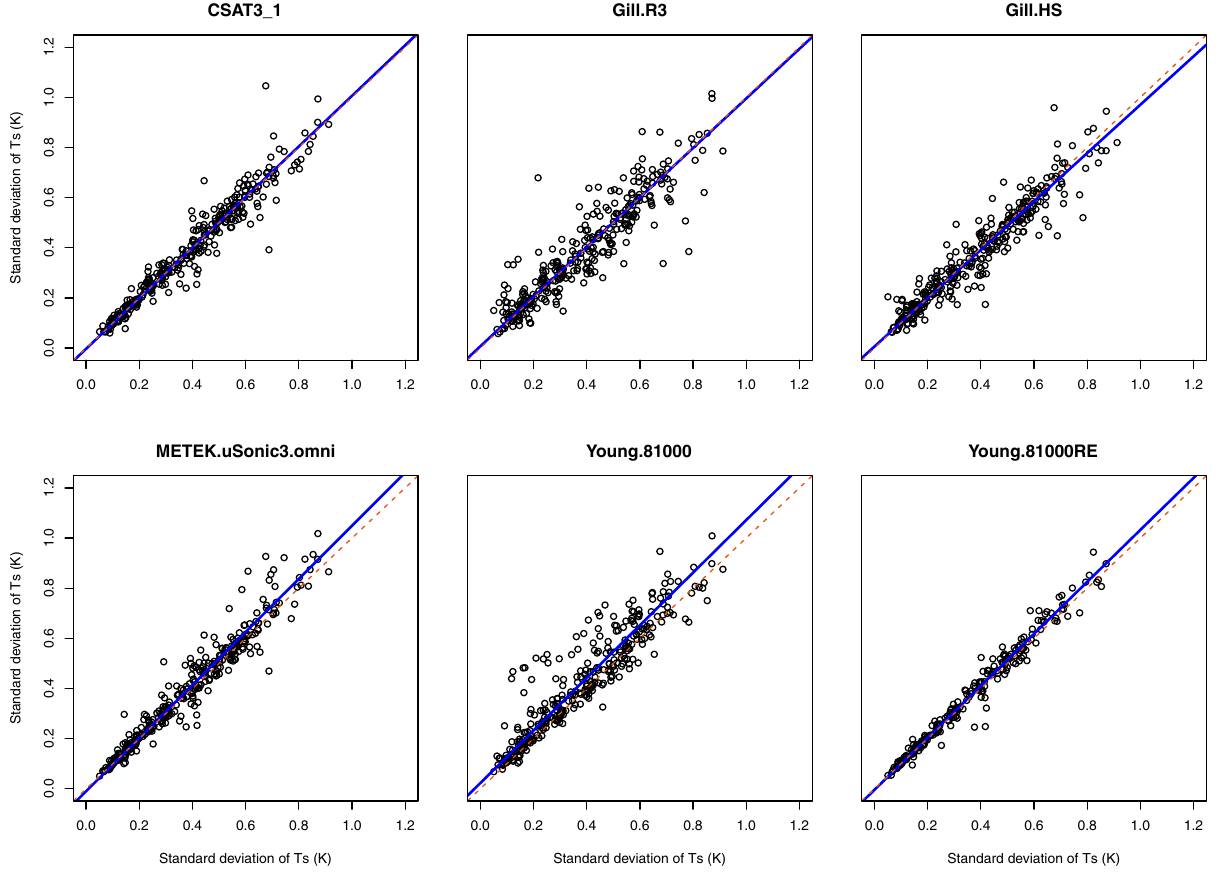
(etalon = CSAT3_2). s , plus estimates for bias and comparability (RMSE); unusually s